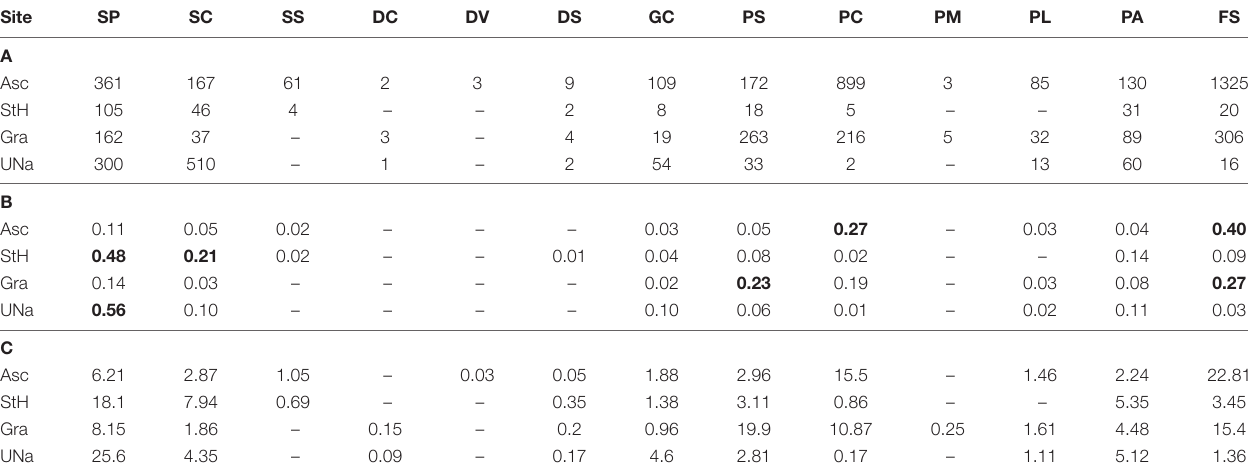
TABLE 1 | Occurrence of each biodiversity functional group by site.